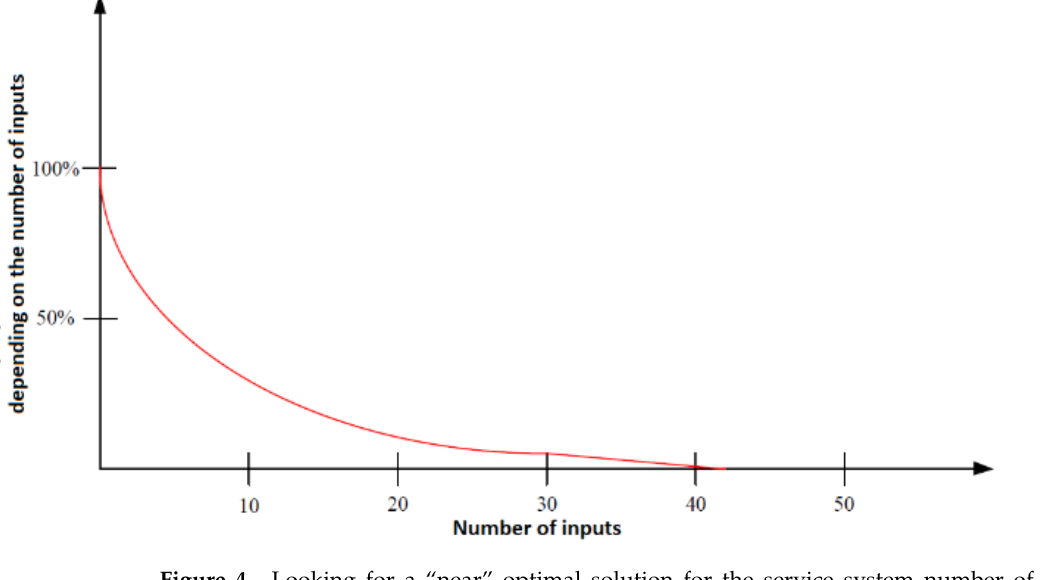
Figure 3. The above-described process of assigning random call time on an over-dimensioned scale.